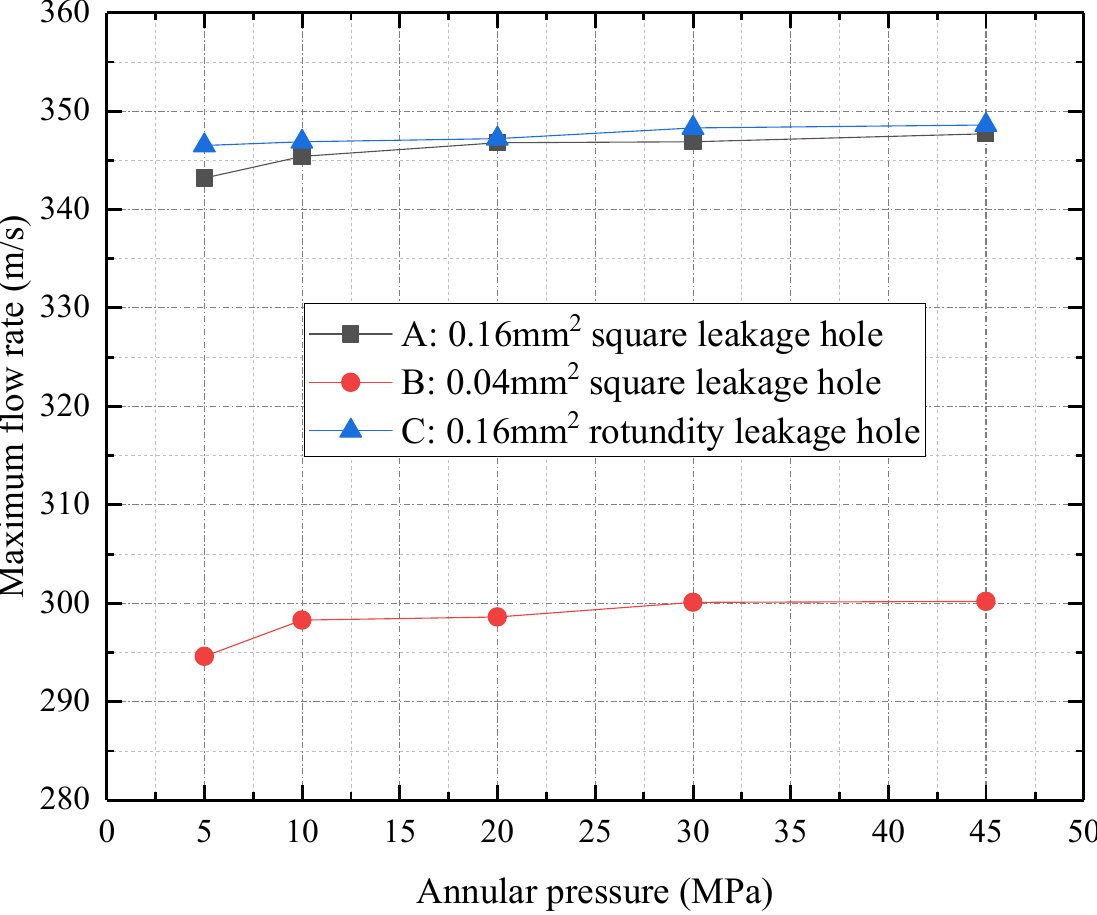
Figure 7. Maximum flow rate under different leakage hole shapes, sizes, and annular pressures.